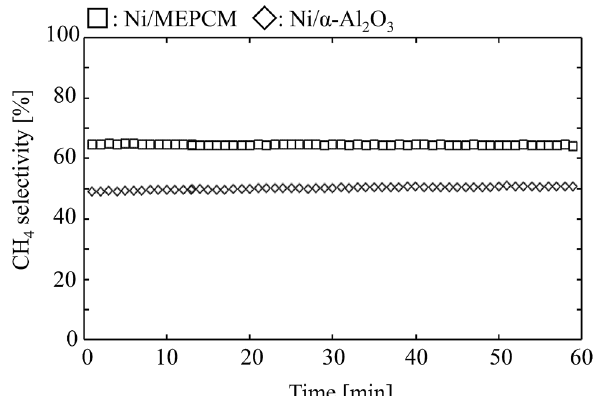
Figure 9. CH 4 selectivity of the Ni/MEPCM and Ni/α-Al 2 O 3 . Reaction condition: F in , CO 2 = 10 ml min −1 , F in , H 2 = 40 ml min −1 , F in , Ar = 110 ml min −1 , Reaction temperature: 400